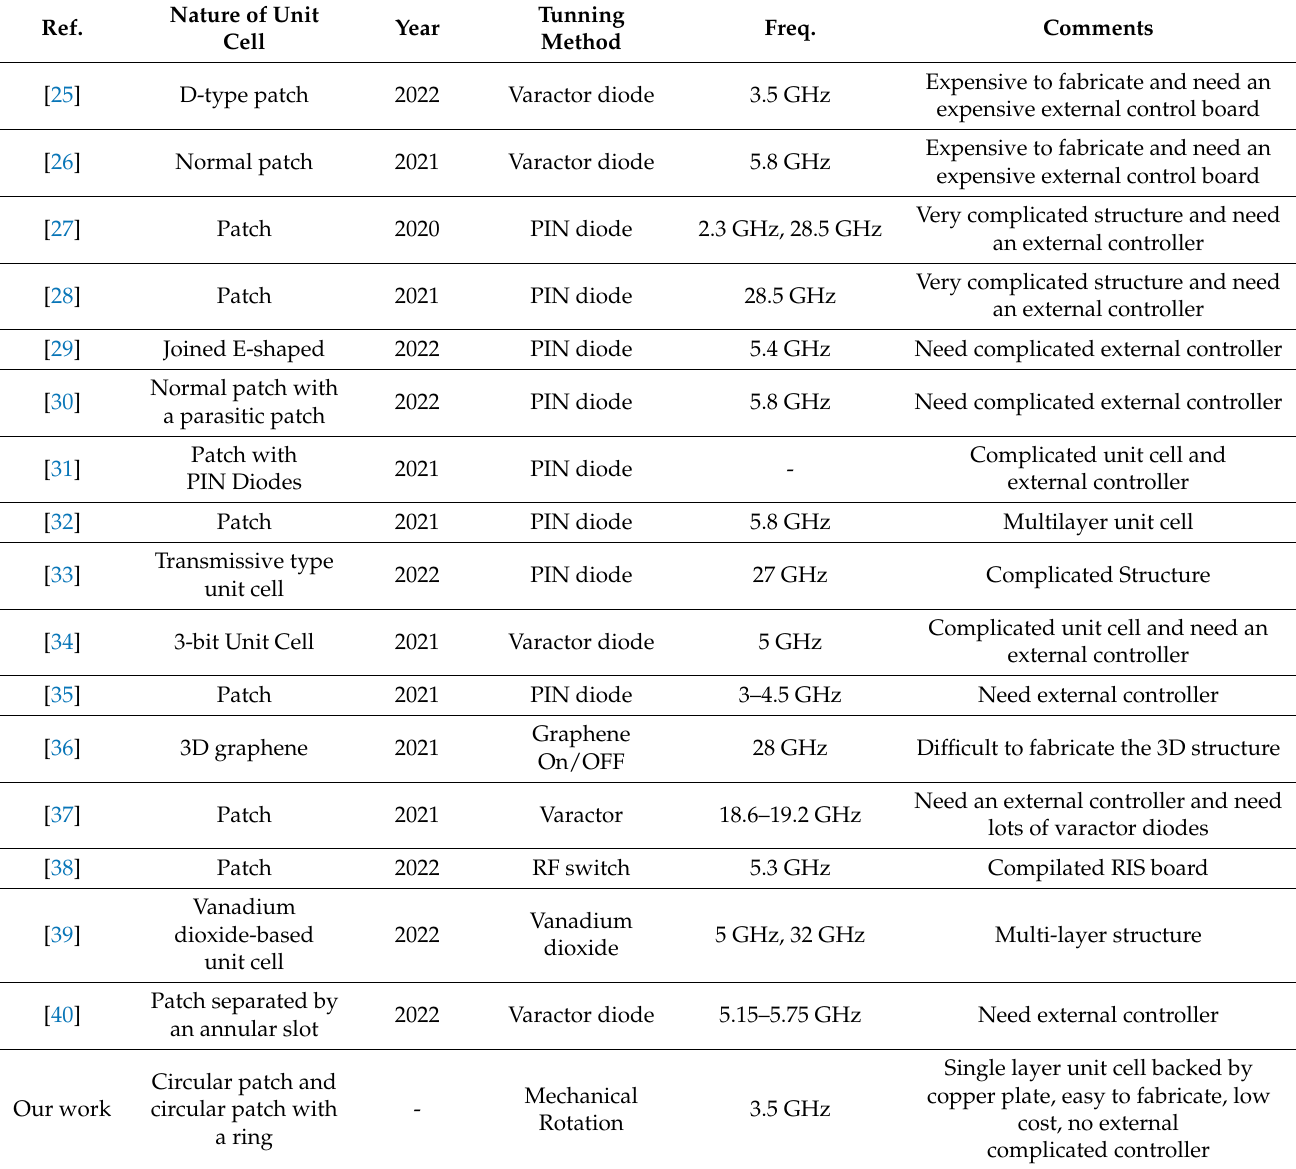
Table 1. Comparison of different types of RIS proposed in the